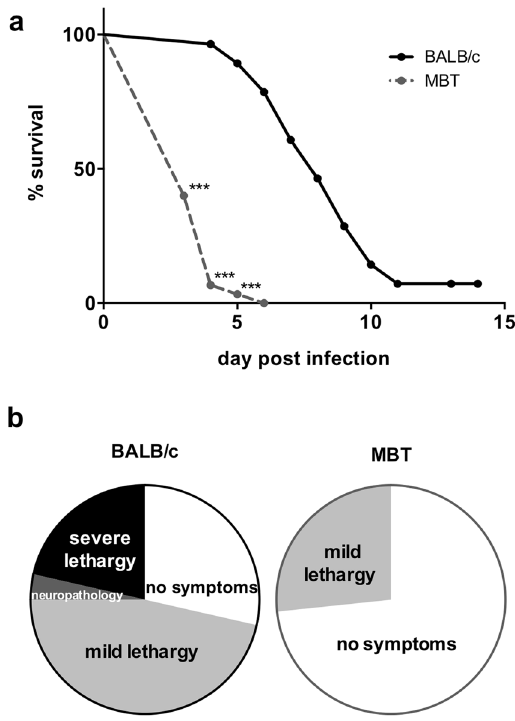
Figure 1. Host genetics contributes to susceptibility and symptoms of RVF disease. (a) Survival curves of BALB/c (n = 28) and MBT (n = 30) mice infected intraperitoneally with 10 2 PFU RVFV strain ZH548. (b) Trajectory of symptoms of these mice as observed daily, preceding death. Mantel-Cox’s Logrank test was performed to assess survival curve differences. *** P < 0.001.